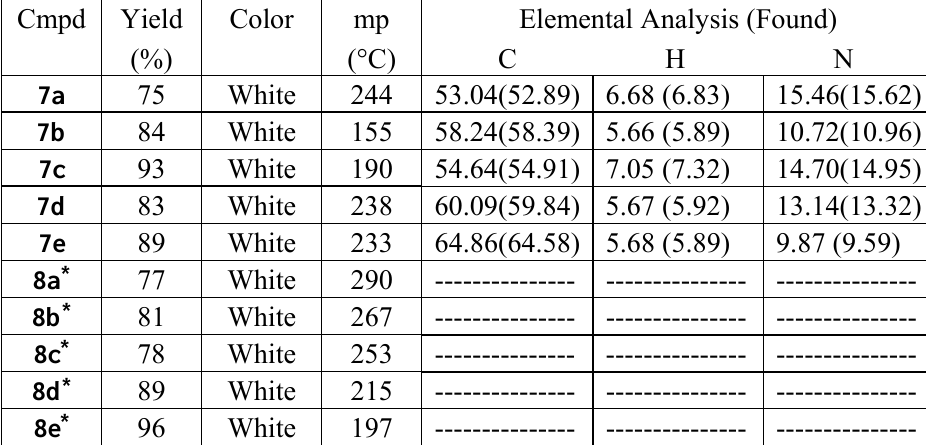
Table 1. Yields, Color, Mps., and Elemental Analyses of Compounds 7 and 8